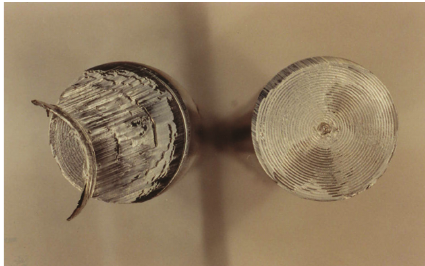
Figure 16: The surface of the AlMg3 aluminium alloy-X10CrNi- Ti189 austenitic steel joint, after the shearing test (parameter no. 1) (according to [26]).